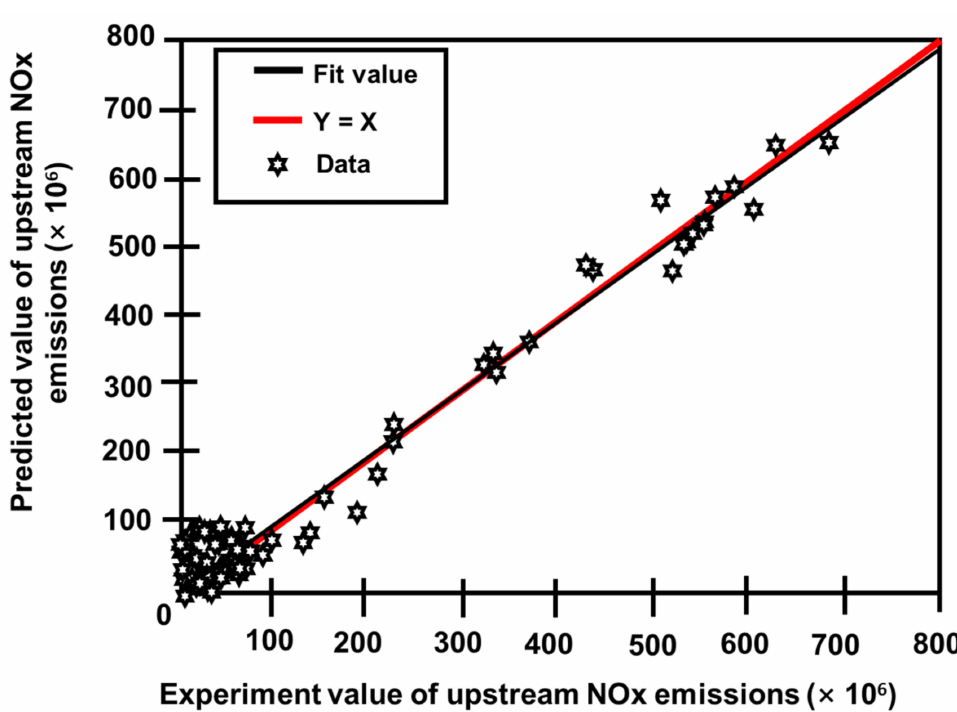
Figure 25. Comparison of observed and projected ammonia slip values [92].